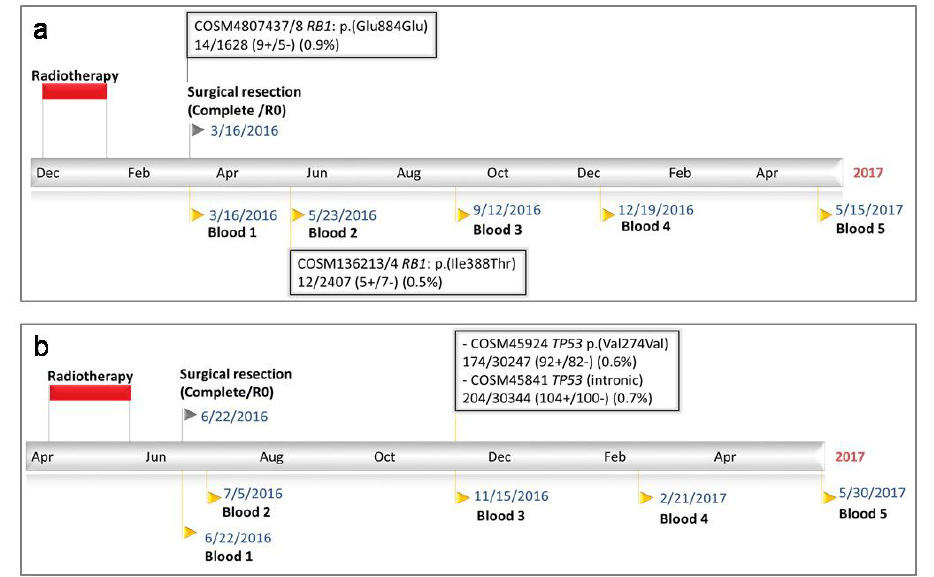
Figure 2. Circulating SNVs detected using tNGS (‘Sarcoma V2’) in STS patients. Figures a and b show data for patient 21 and 23